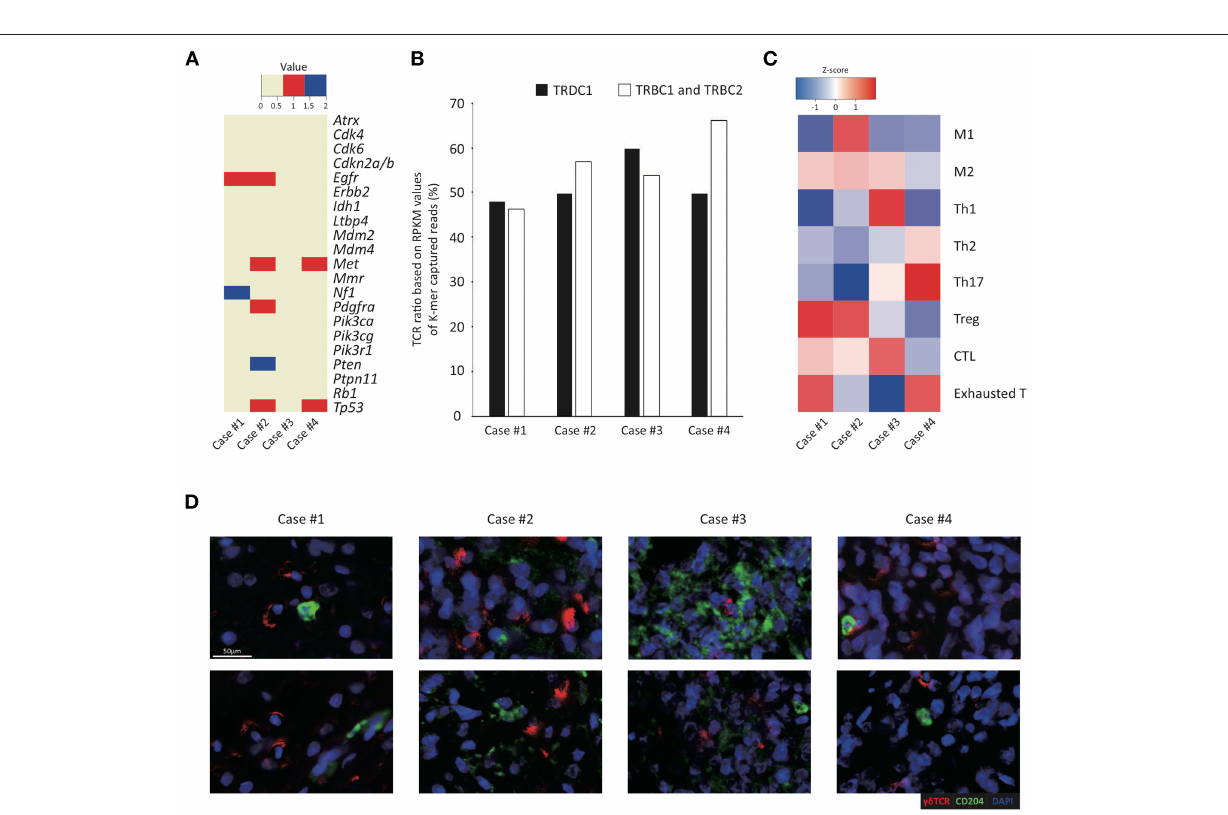
and Th2 cells, respectively. Notably, the γδ T cell activity